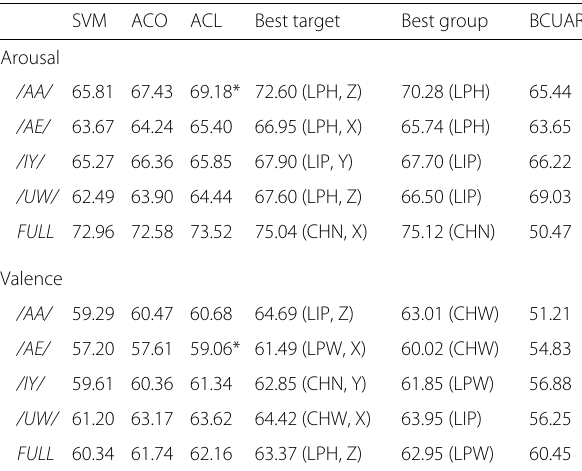
Table 6 Within-corpus results for binary classification on the USC IEMOCAP